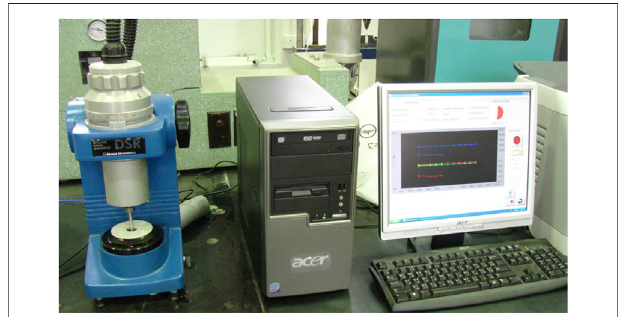
FIGURE 1 | Dynamic shear rheometer (DSR) used in the study.